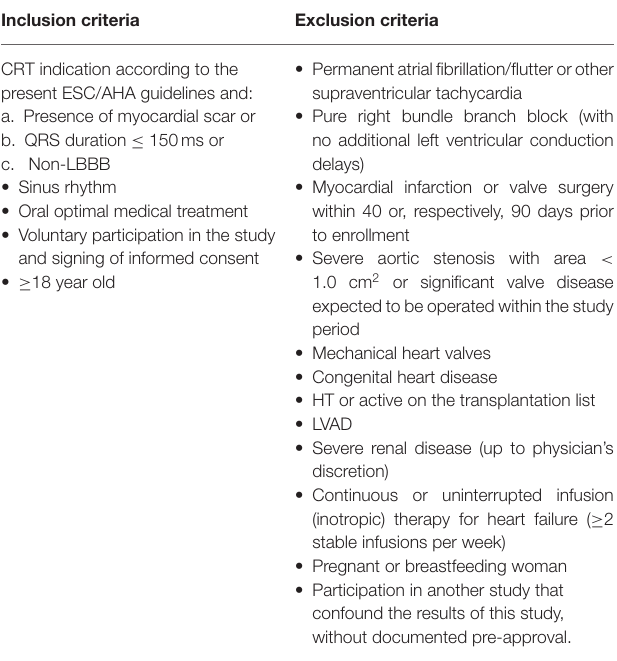
TABLE 1 | Study inclusion and exclusion criteria.